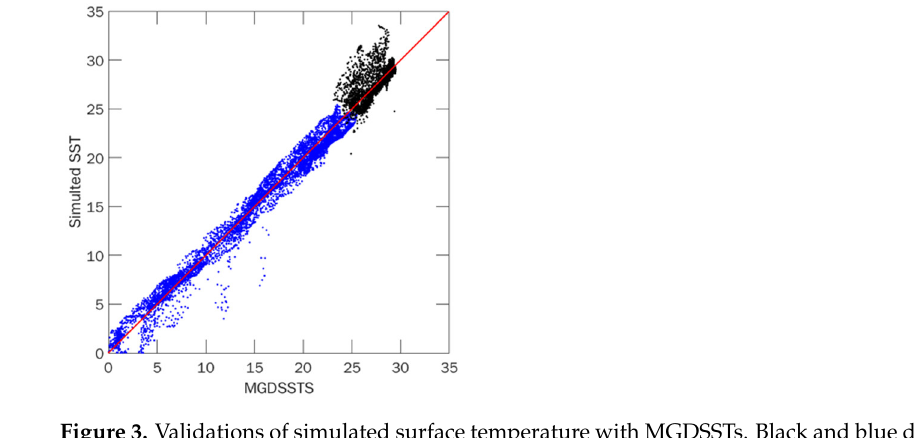
Figure 3. Validations of simulated surface temperature with MGDSSTs. Black and blue dots represent summer and winter values, respectively (unit: °C).